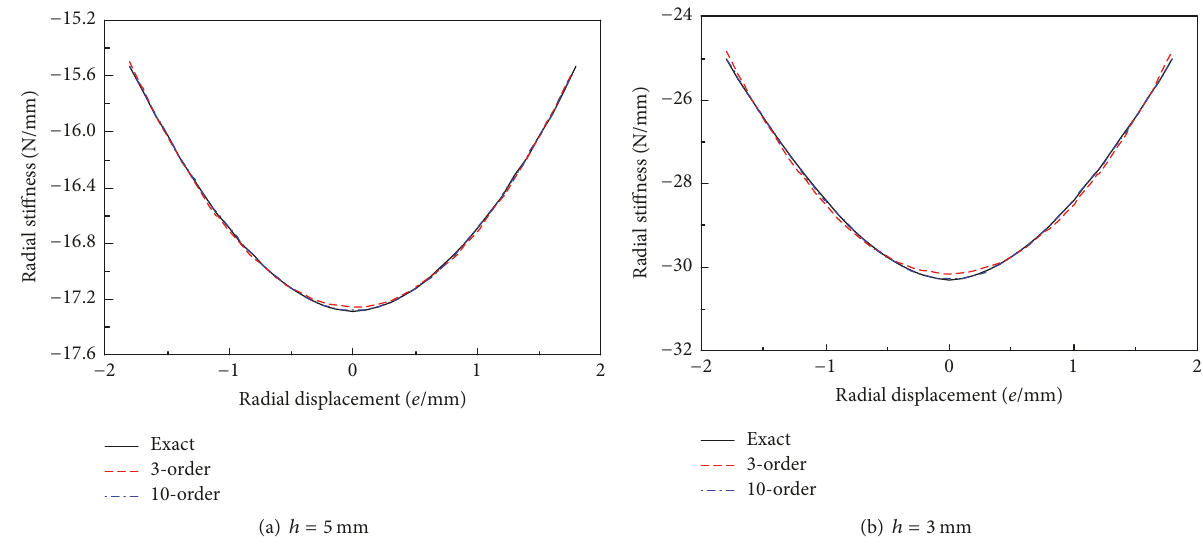
Figure 2: Taylor-expansion and stiffness approximation comparison when ℎ are 5 mm and 3 mm, respectively.